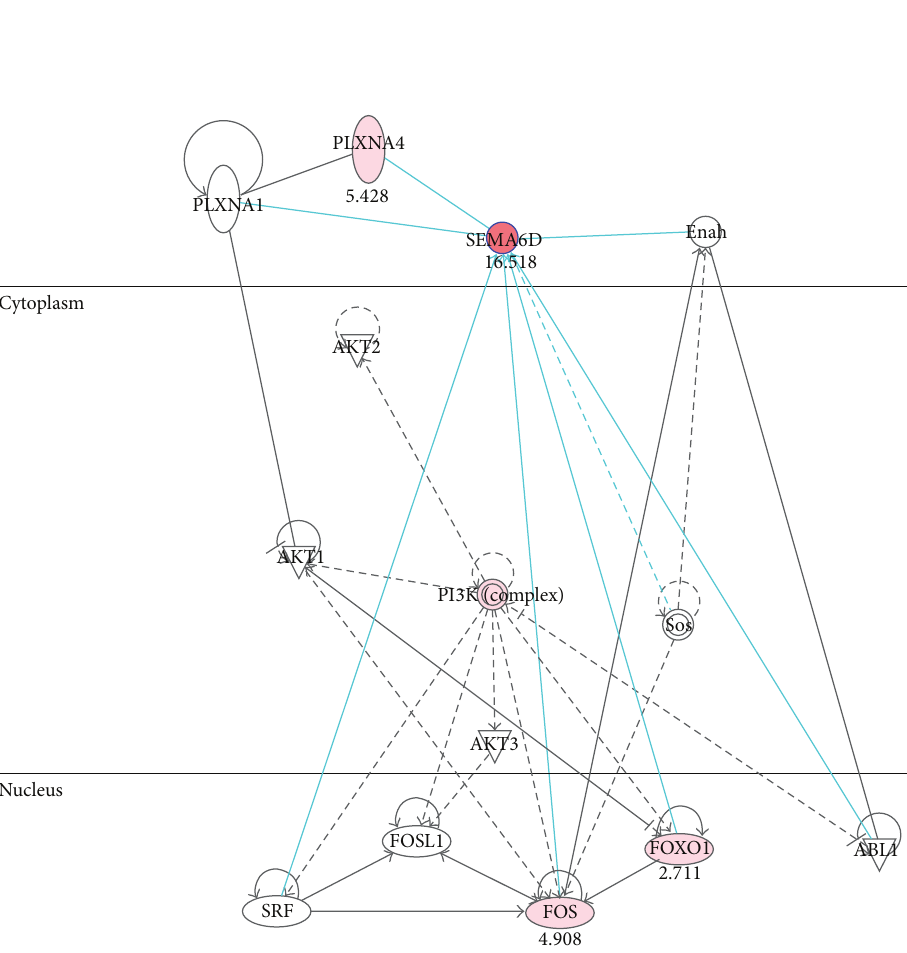
Figure 4: Activation of SEMA6D and transcription. The gene-gene interaction network was built based on direct interactions by using Ingenuity Pathway Analysis (IPA) suite. Color indicates increased (in red) expression when SEMA6D-high samples were compared with SEMA6D-low samples. The number indicated the fold changes of this